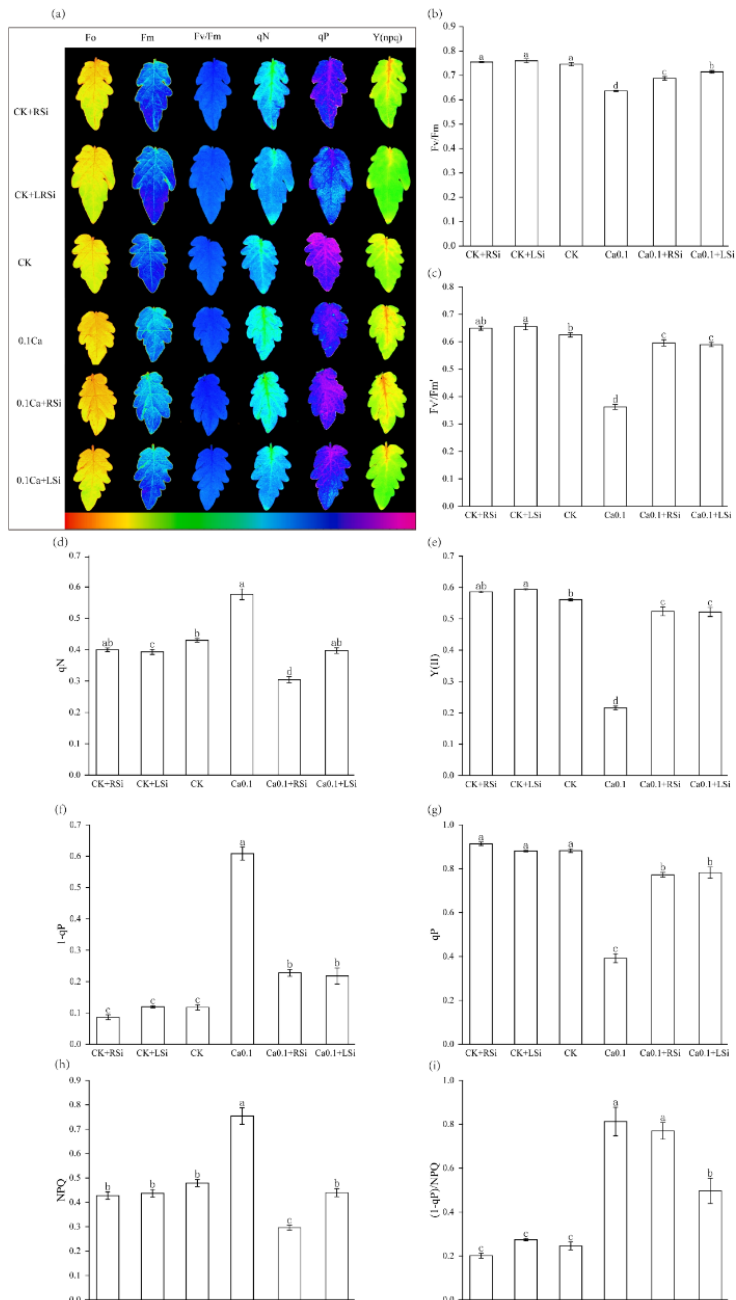
Figure 5. Effect of exogenous Si on fluorescence parameters of tomato leaves under low − calcium stress. ( a ) Fluorescence imaging of tomato leaf; ( b ) Fv/Fm: maximum photochemical efficiency; ( c ) Fv’/Fm’: effective photochemical quantum yield; ( d ) qN: nonphotochemical quenching coefficient; ( e ) Y(II): actual photochemical efficiency; ( f ) 1 − qP: PSII excitation pressure; ( g ) qP: